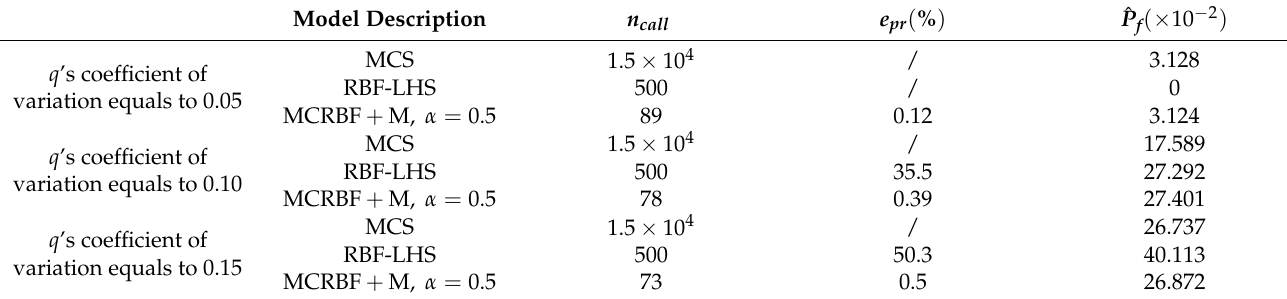
Table 6. The results for example